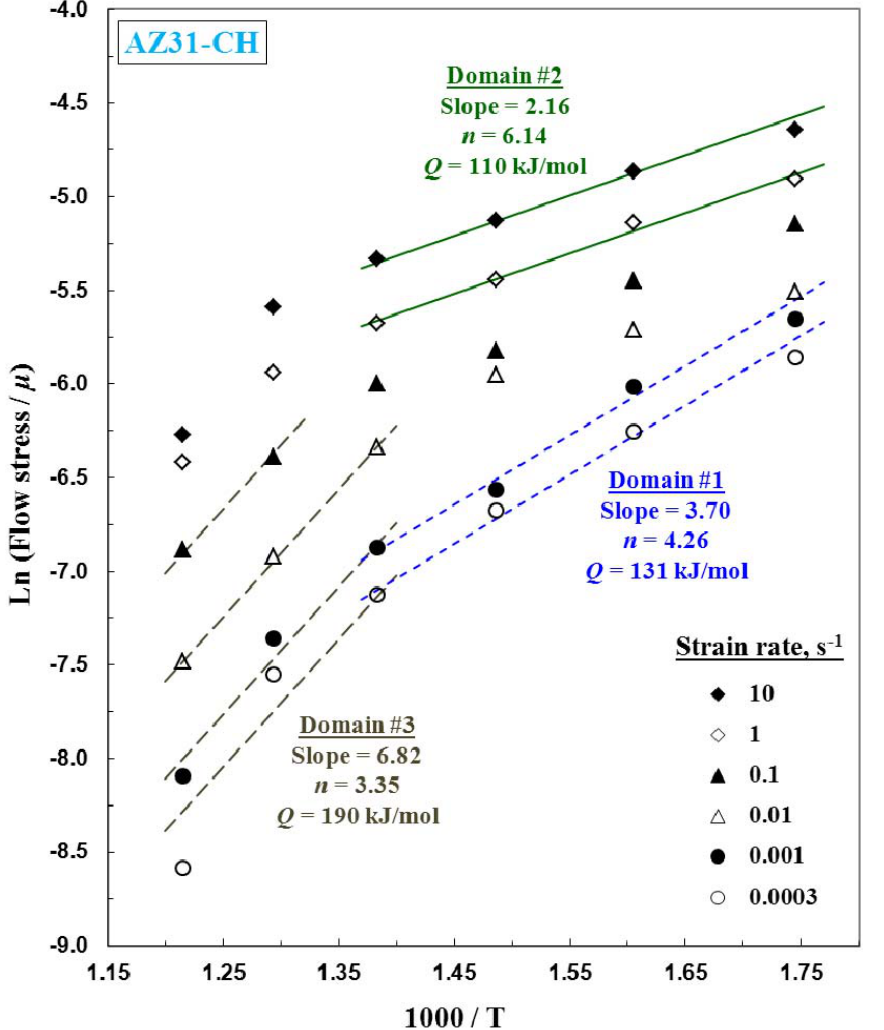
Figure 4. Arrhenius plot for calculating apparent activation energy in the three domains of processing map for cast-homogenized AZ31 magnesium alloy (near-random